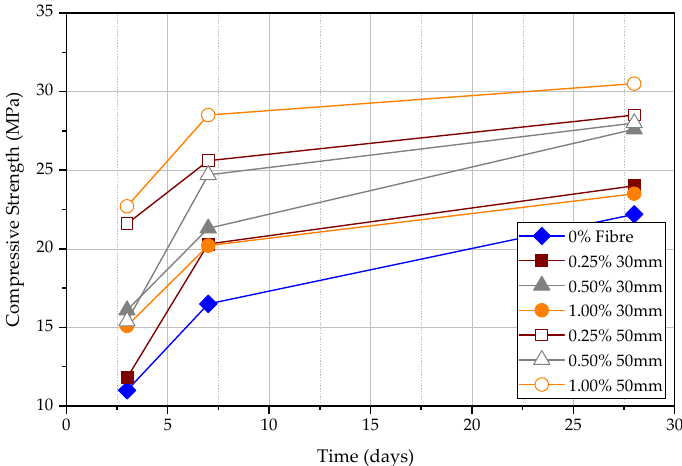
Figure 9. Compressive strength (MPa) using rebound hammer test result.